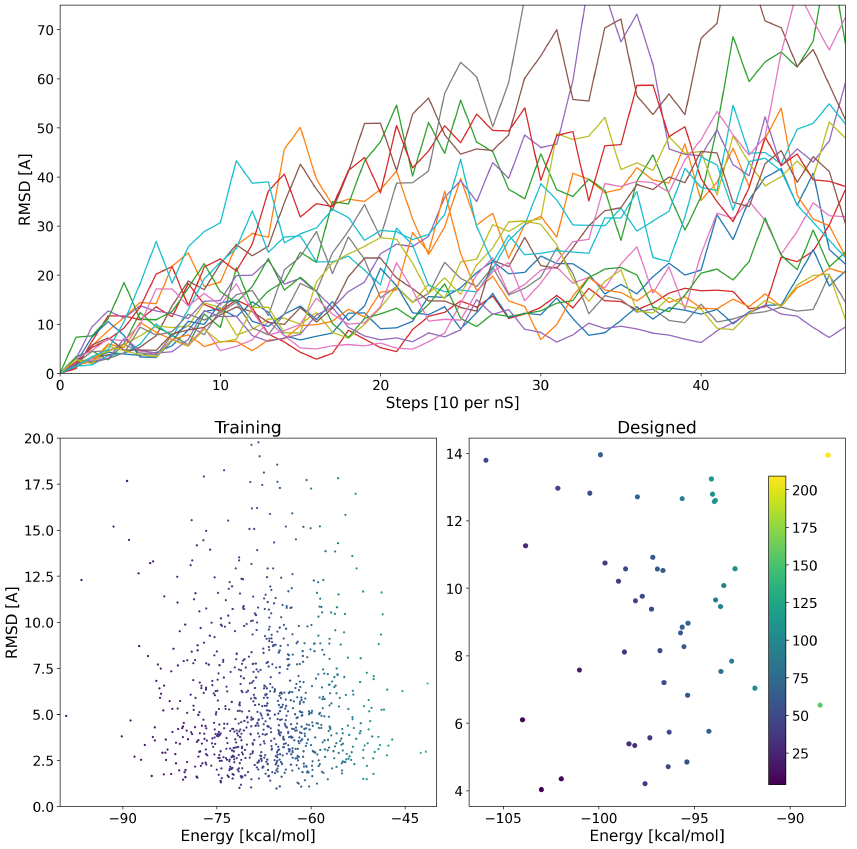
Figure 3. Top panel: The trajectories of RMSD of 10 random complexes over 5ns. It is evident that some designs are more stable and remain within their original conformation from design (low RMSD), whereas others deviate greatly from their original design coordinates (high RMSD). Bottom panel: The binding energy of different complexes and their corresponding coordinate RMSD. The best designs (low energy and stable) are plotted in blue while less reliable ones become more